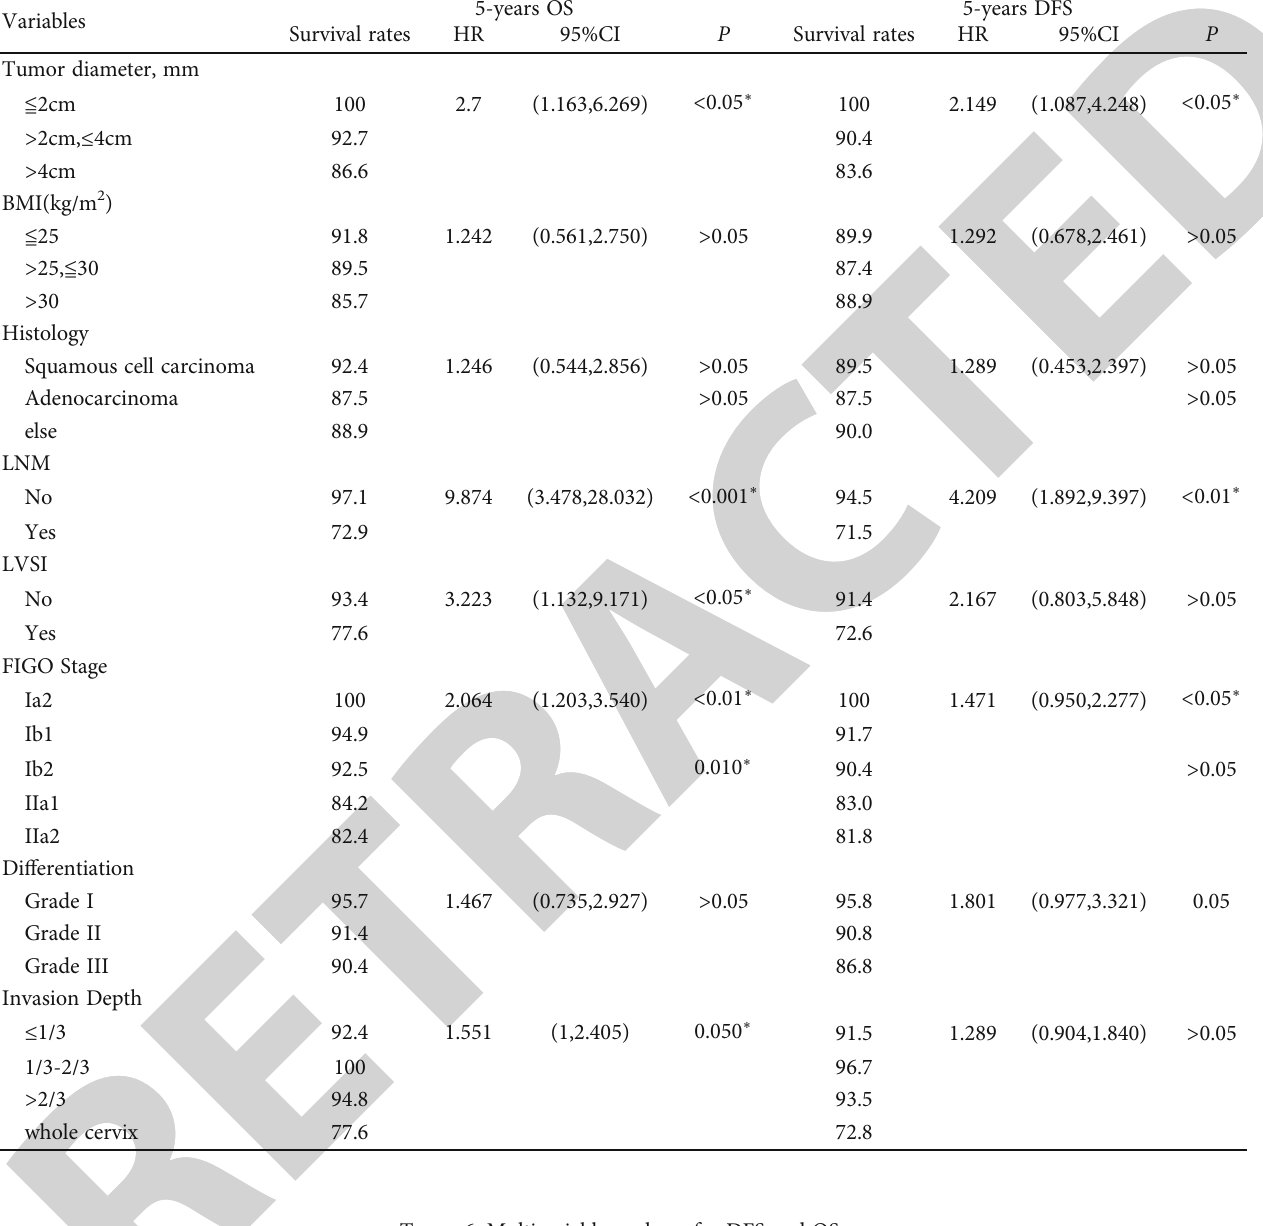
Table 5: Univariable analyses for DFS and OS.